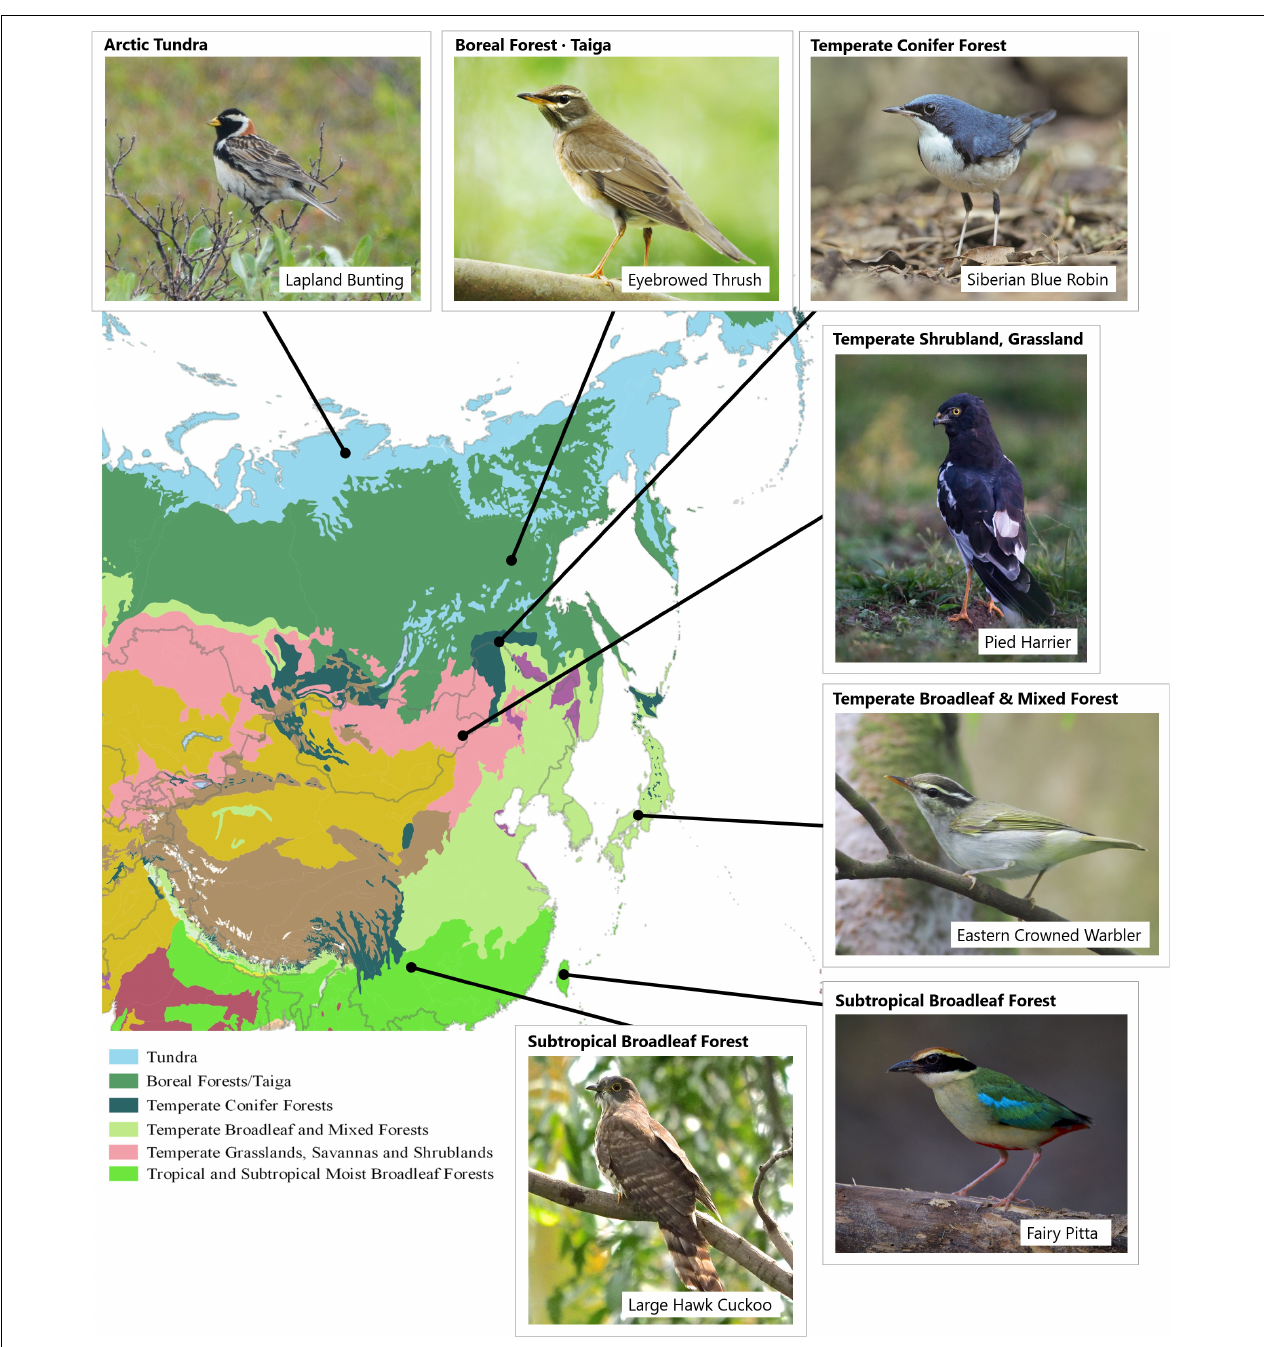
FIGURE 3 | Six major biomes in northeast Asia form the breeding range of most migratory landbirds in the EAF (Image credits: Pavel Ktitorov, Tiah Khee Lee, Heng Yee Cheng, Yann Muzika, Bjorn Olesen, Geoff